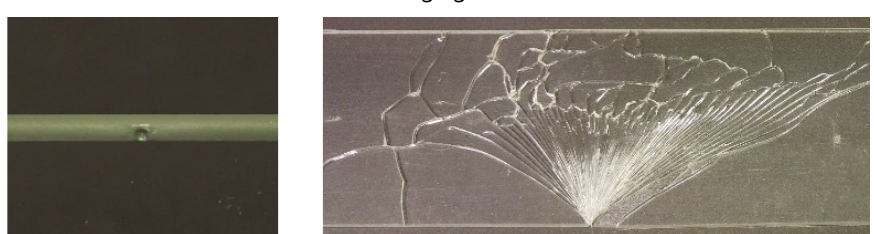
Fig. 4 Detail of a flaw on the edge of the sample tested and corresponding cracking pattern